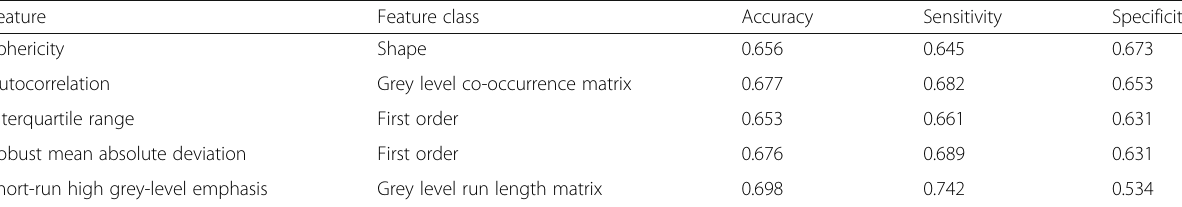
Table 4 Performance metrics of the five features with area under the curve > 0.6 to differentiate low and high Ki-67 expression on digital breast